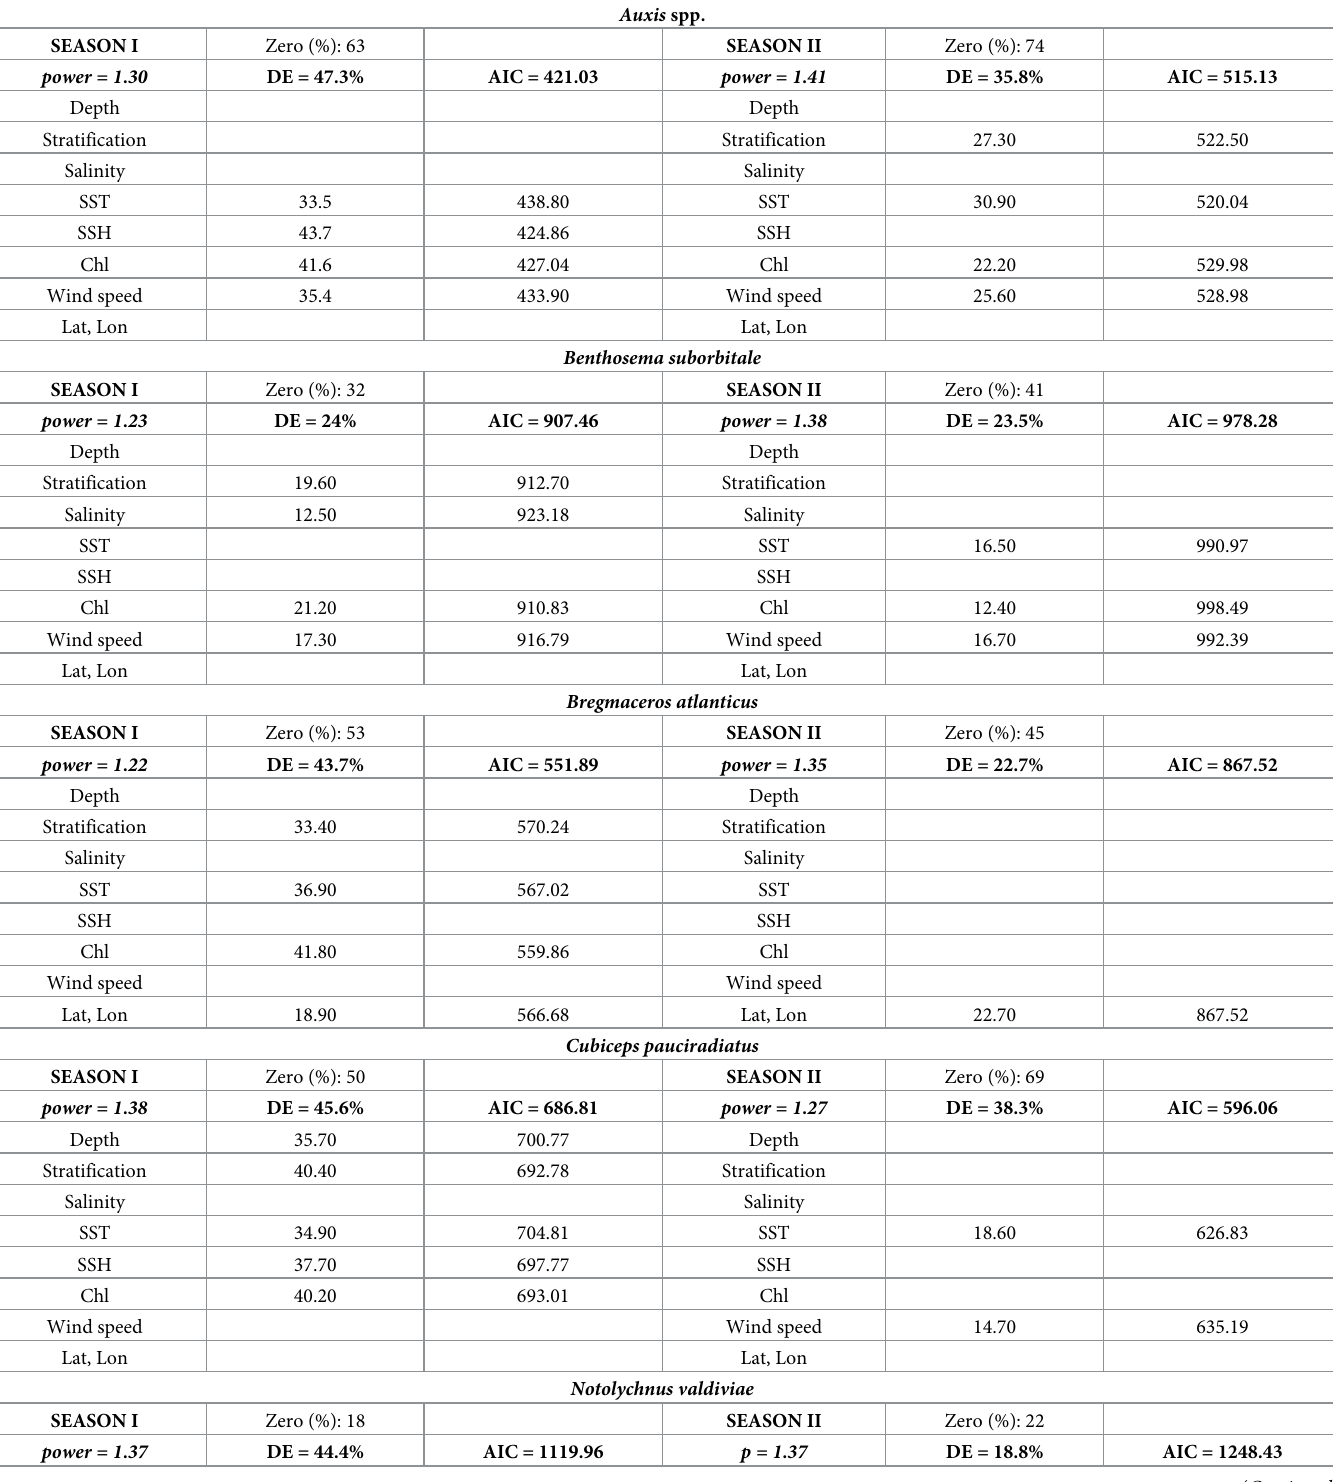
Table 5. Final GAMs for each target species with significant environmental and spatial variables divided by season (Season I: April to July; Season II: August to October).